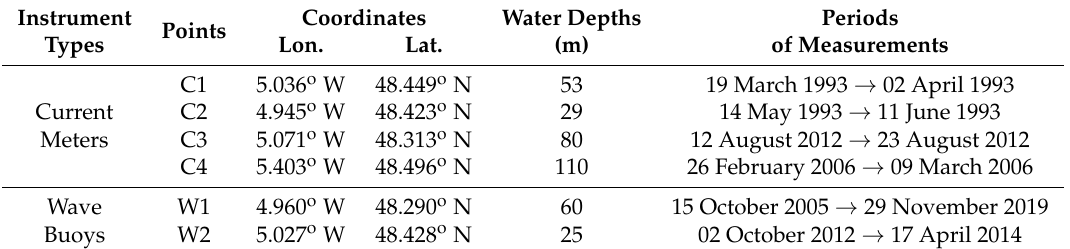
Table 1. Description of current and wave measurement campaigns in Ushant-Molène